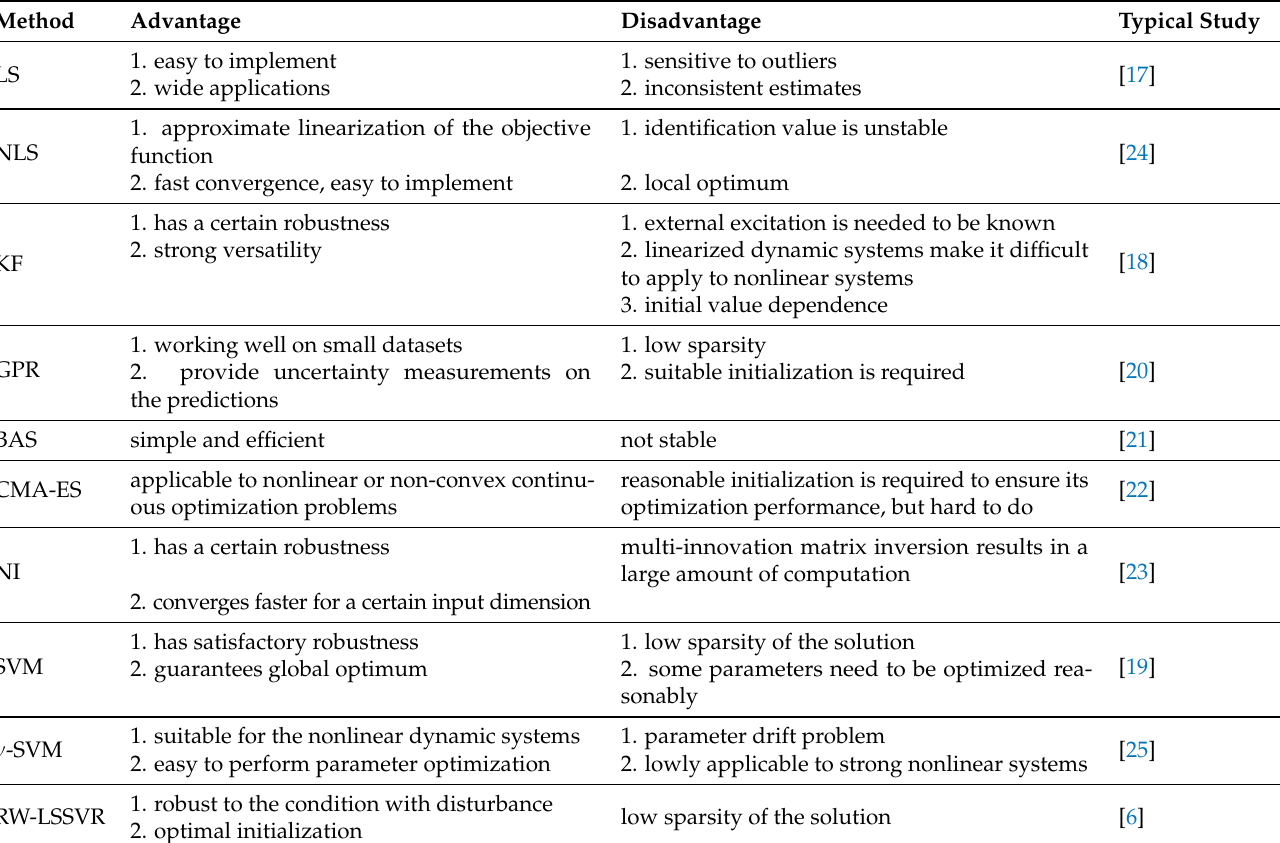
Table 1. Comparative analysis of the identification